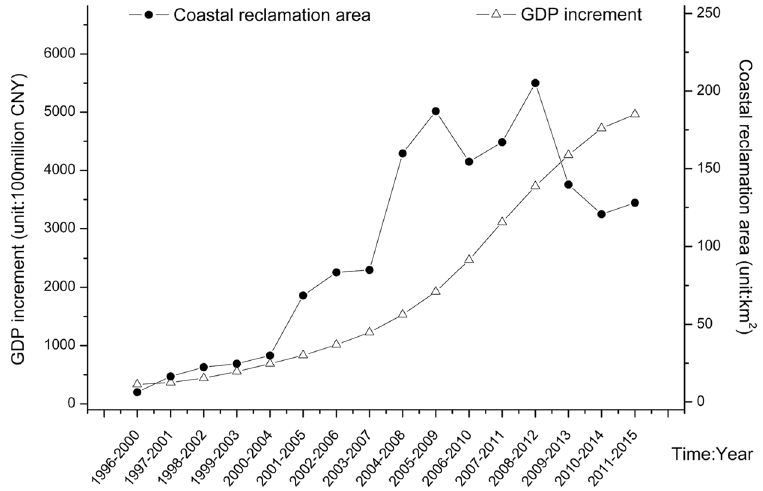
Figure 3. Graph of coastal reclamation area and GDP growth.